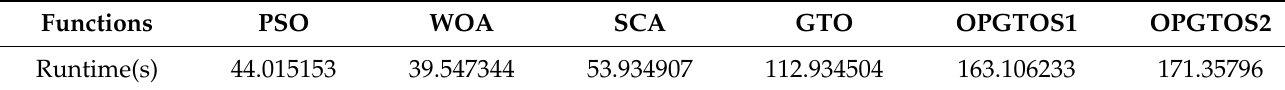
Table 5. Average solution time on CEC2013 in 30 dimensions.